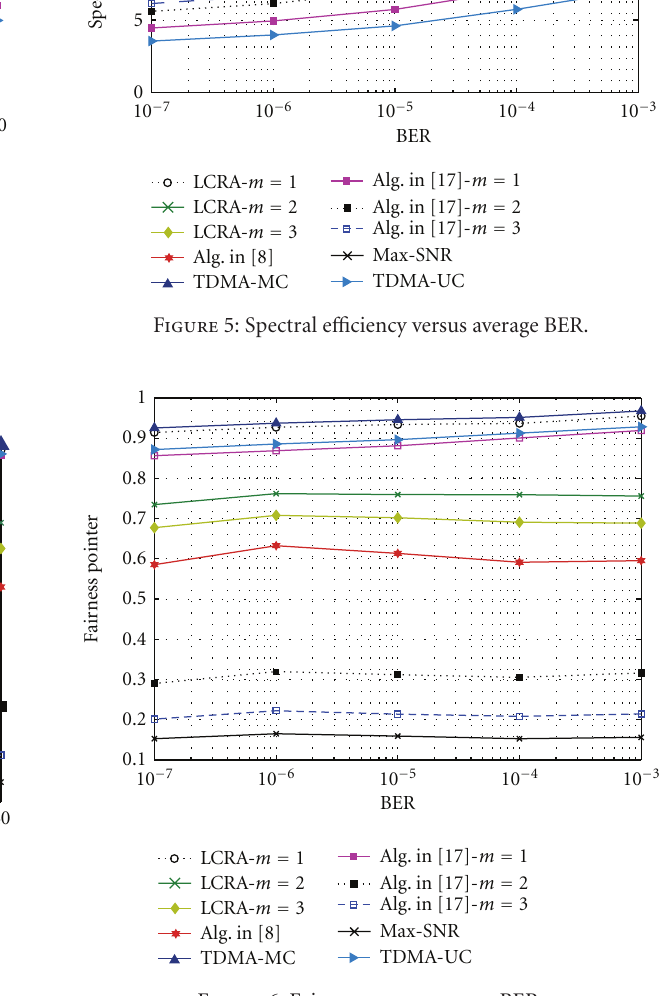
Figure 6: Fairness versus average